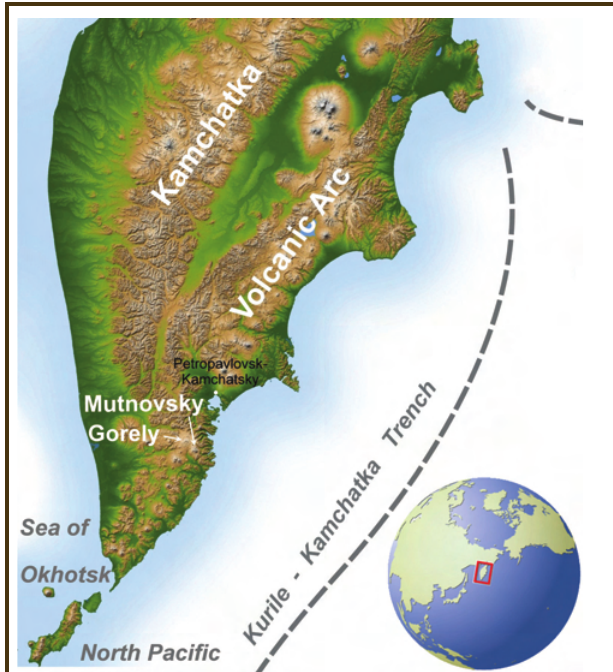
Figure 1. Kamchatka Peninsula with location for Mutnovsky and Goroly volcanoes shown (from Lees et al., 2007; image from http://earthob- servatory.nasa.gov/images/imagerecords/2000/2967/PIA03374_lrg. jpg) and http://maps.grida.no/go/graphic/kamchatka_sites.